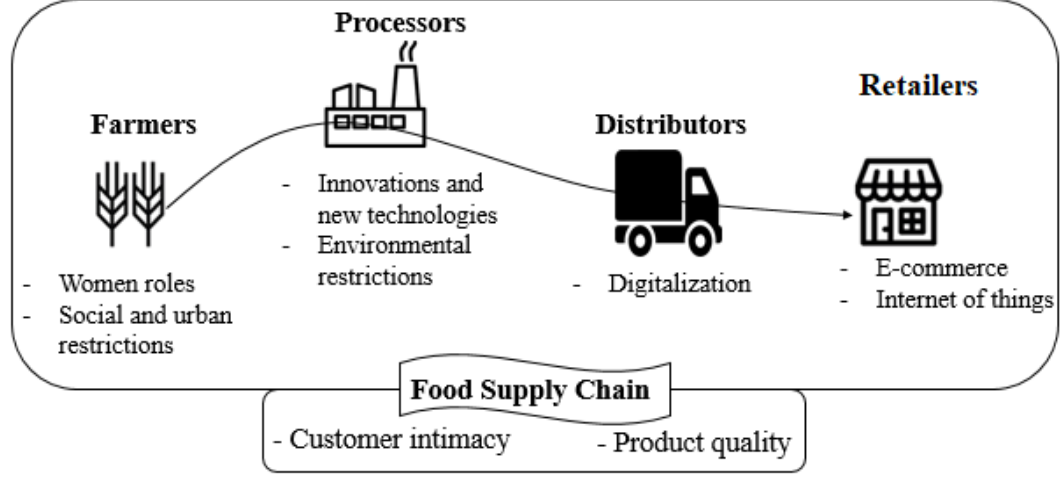
Figure 8. The business model innovation driving forces in the food supply chain.